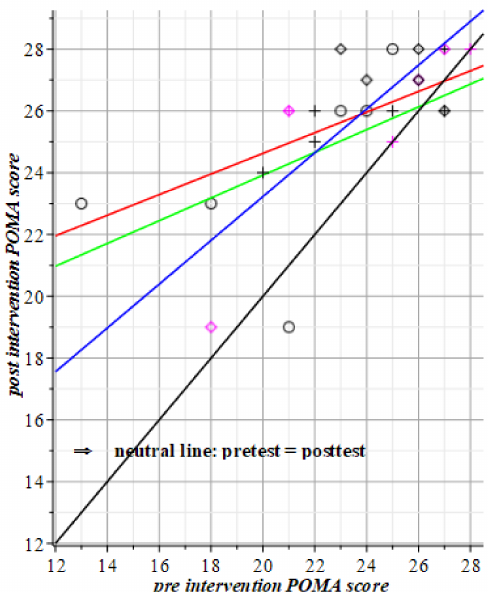
Figure 7. The results of the three groups in green, blue, and red lines. The no-results, or neutral line is black. All groups are above the black line, so they all made progress, compared to their respective pre- intervention scores. The visuo-spatial-motor group performance shows a break-even point at about T 0 = 22. This means that initially, vigorous subjects perform better at POMA after the visuo-spatial- motor intervention than vigorous subjects would profit from the only motor intervention. For frail subjects w.r.t. the POMA score result is opposite: Until intake score T 0 = 22, the motor intervention only is more beneficial than the visuo-spatial-motor intervention. Red datapoints represent male subjects. Circles and green line: Motor group T 1 = 16.55 ( ± 1.82) + 0.37 ( ± 0.31) T 0 ( POMA ) . Rhombus pts., blue: Visuo-spatial-motor group, T 1 = 9.05 ( ± 5.36) + 0.71 ( ± 0.22) T 0 ( POMA ) . Plus signs, red line: Control group, T 1 = 17.95 ( ± 0.77) + 0.33 ( ± 0.33) T 0 ( POMA ) .